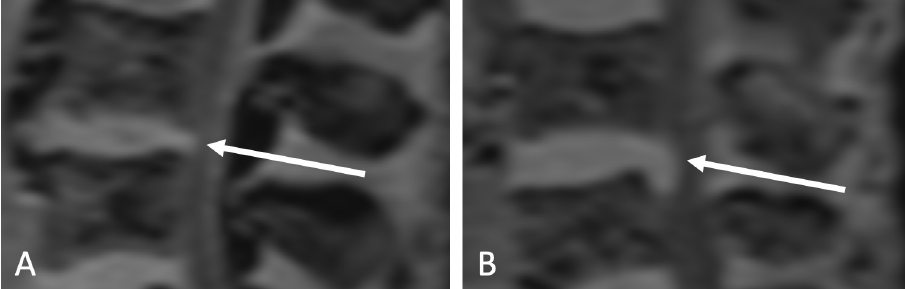
Fig 4. Image example of disc bulging (A) and disc protrusion (B) on L3/4 as indicated by the arrows (MRI sequence: VIBE Dixon Iso W).